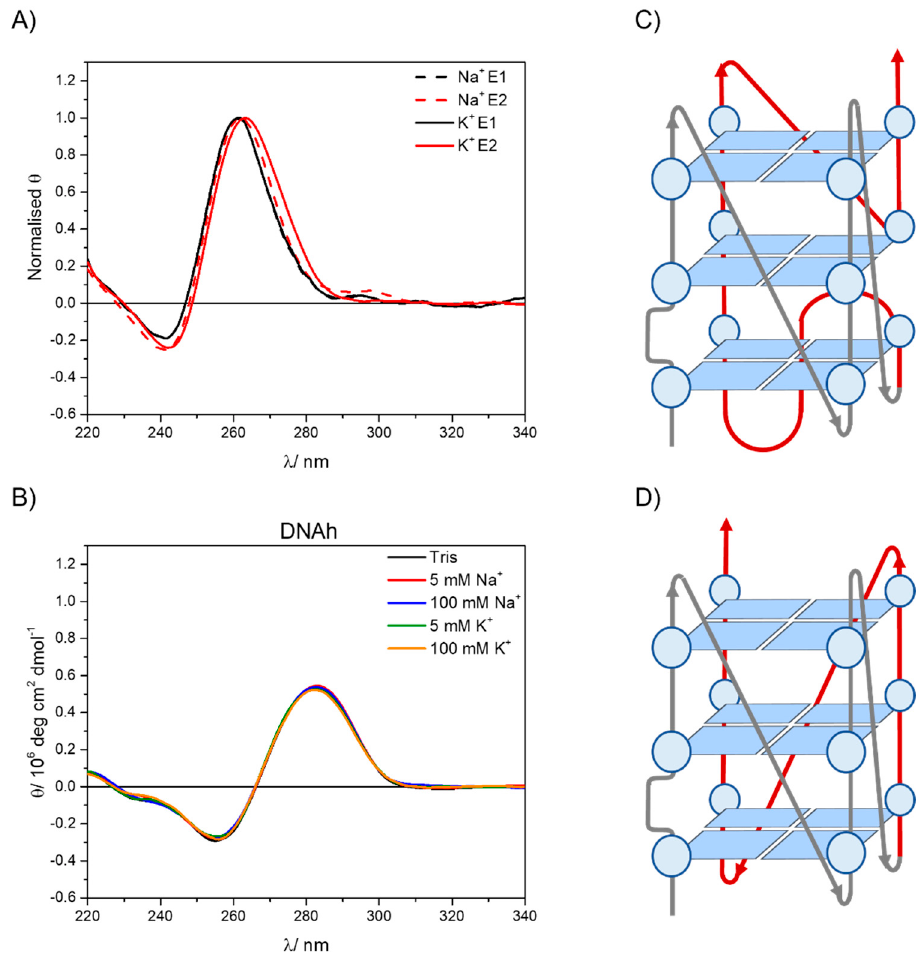
Figure 4. ( A ) Normalized pure spectra obtained from the non-linear global analysis of the CD titration data for the GCG6AG7 sequence with potassium (black lines) and sodium (dashed lines) using Hill’s equation. ( B ) CD spectra of DNAh in a Tris buffer and different added sodium and potassium concentrations. ( C ) Proposed structure for the less ordered, ( − p − p − p+p) parallel G4. ( D ) Proposed structure for the highly ordered, − (ppp) parallel G4.